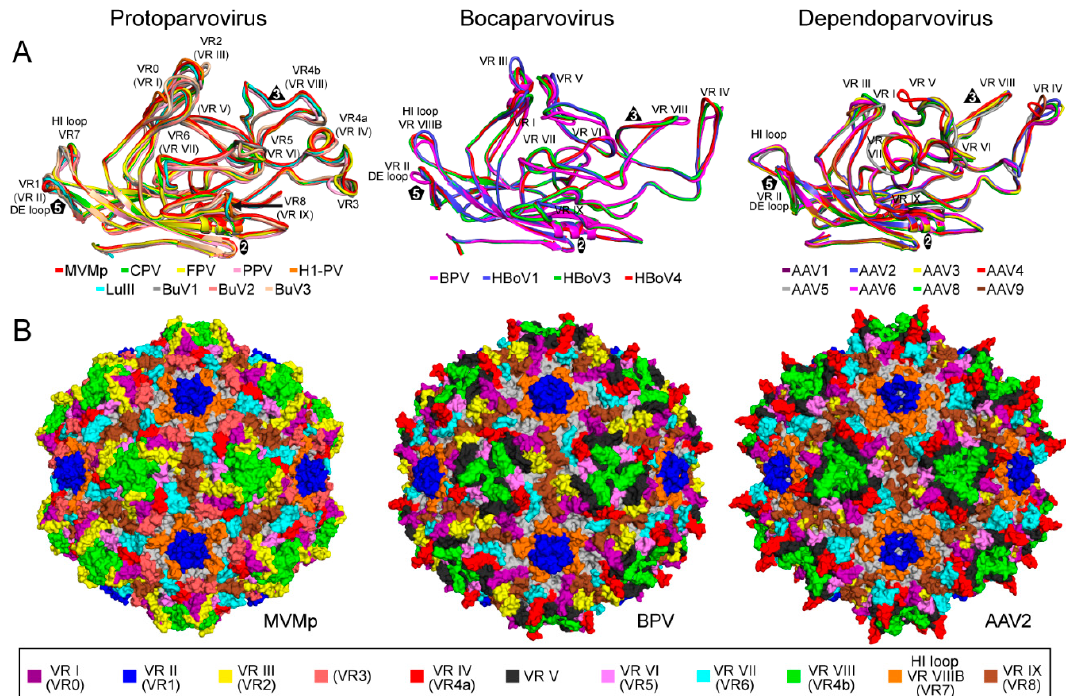
Figure 6. The structure of a VP monomer of CPV (PDB ‐ ID: 2CAS). A cartoon ribbon diagram is shown. The beta strands ( β A to β I, gray), α‐ helix A (red), interconnecting surface loops (with all secondary structure elements removed, green), and the N ‐ and C ‐ terminus are indicated. The approximate icosahedral 2 ‐ fold, 3 ‐ fold, and 5 ‐ fold axis are indicated by an oval, triangle, and pentagon, respectively. This image was generated using PyMOL [77].